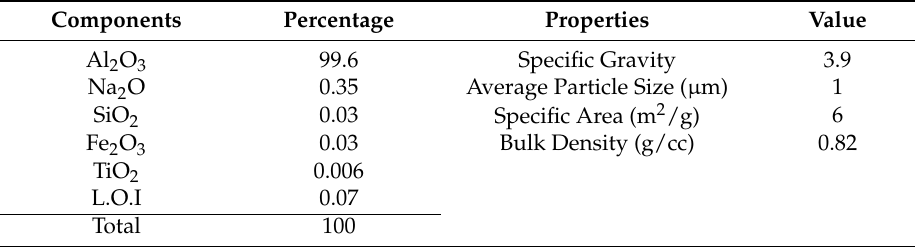
Table 2. The analysis of the α -Al 2 O 3